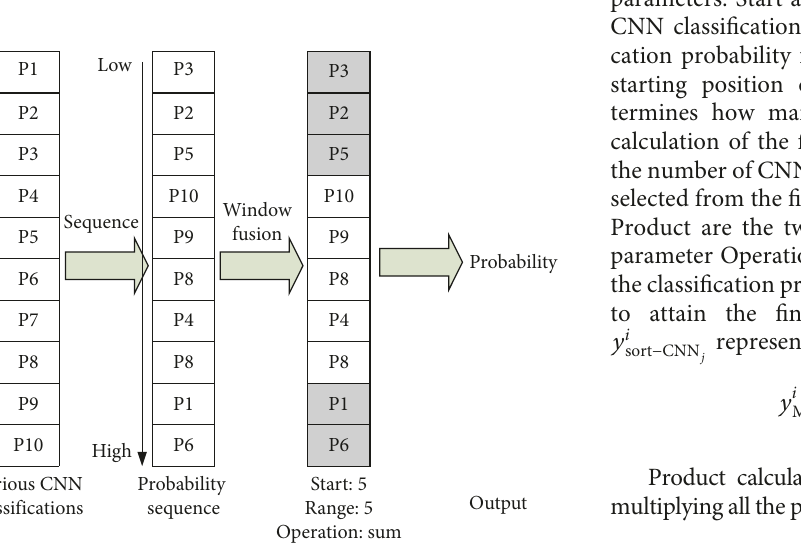
Figure 2: Schematic diagram of the sliding window fusion method for multilayer CNNs.